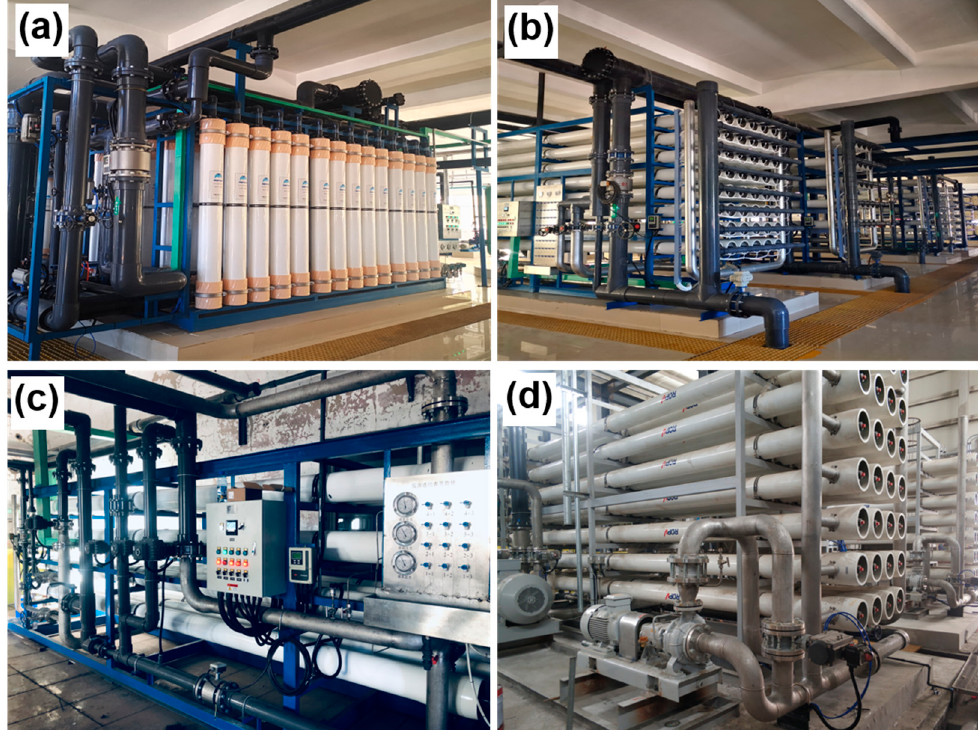
Figure 7. Desalination technologies used in industrial wastewater treatment projects from ISDMU. The ultrafiltration ( a ) and RO ( b ) systems for Lianyuan power plant project, Neimeng. ( c ) Temier power plant project, Neimeng. ( d ) Tianyu coal chemical industry project, Xinjiang.